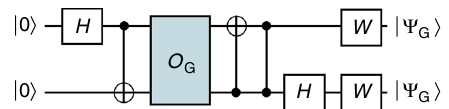
Fig. 6 Security of probabilistic one-time programs. We demonstrate that the ability to make a single query to the (ideal) classical gate allows us to have 2 copies of state | ψ G 〉 . The quantum circuit shown in the fi gure produces two copies of the state | ψ G 〉 for any G 2 G 1 using only a single query of O G which is an implementation of a reversible version of the encoded gate G mapping | x , y 〉 to | x , y ⊕ G ( x ) 〉 and W = [ c , s ; s , − c ], where c = cos( π /8) and s = sin( π /8). As it is not possible to produce two copies of | ψ G 〉 from a single copy, this demonstrates strictly less can be learned from a single copy of output state G k , than from a single (coherent) query to